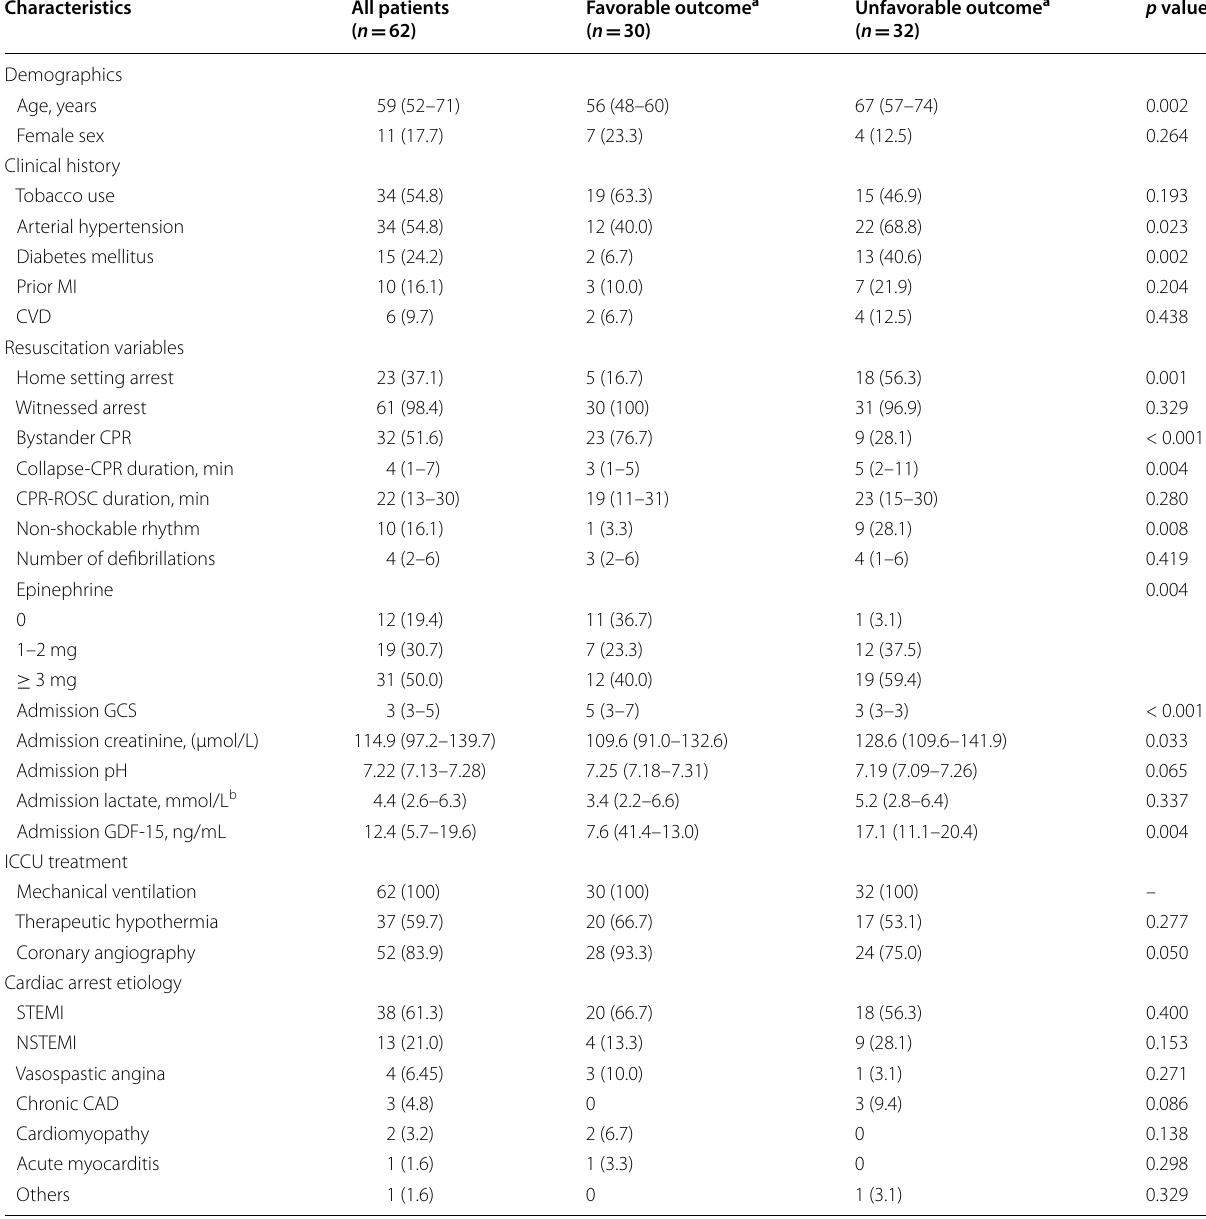
Table 1 Baseline characteristics of the study